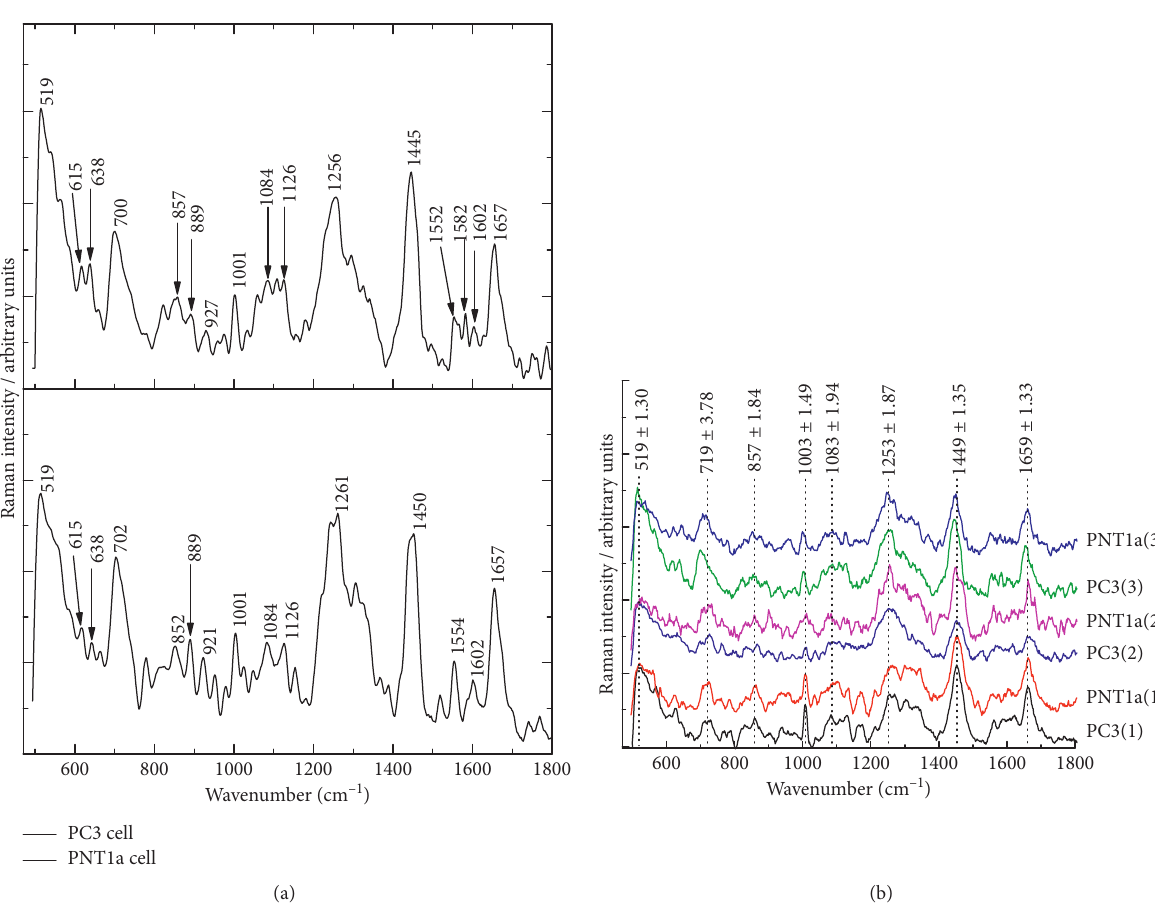
Figure 1: Photomicrographs of (a) PC3 and (b) PNT1a monolayer grown cells on calcium fluoride (CaF with (i) nucleus, (ii) cytoplasm, and (iii) cell wall constituents clearly visible in both